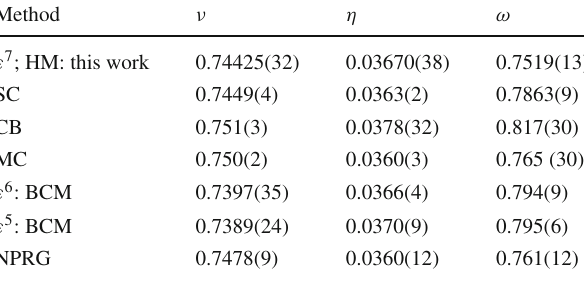
Table 5 The seven-loop ( ε 7 ) hypergeometric-Meijer resummation for the exponents ν , η and ω of the O ( 4 ) -symmetric model compared to results from the SC resummation in Ref. [54], conformal bootstrap calculations[25,32]for ν and ω ,while η fromRef[23],MCsimulations for ω is taken from Ref. [17] while ν and η are from Ref. [13]. Also, the six-loop BCM resummation ( ε 6 ) is taken from Ref. [32] and five-loops ( ε 5 ) from same reference. NPRG results up to O (∂ 4 ) [28] are shown